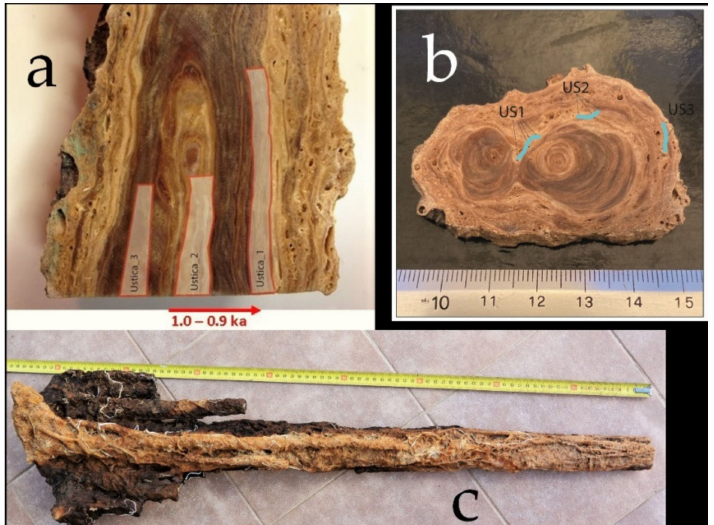
Figure 4. The stalactite sampled at Ustica: ( a ) Longitudinal section with sampling area of U \ Th ages (refer to Table 2); ( b ) horizontal Scheme 1. US2, and US3, refer to Table 3; ( c ) the stalagmite sampled.